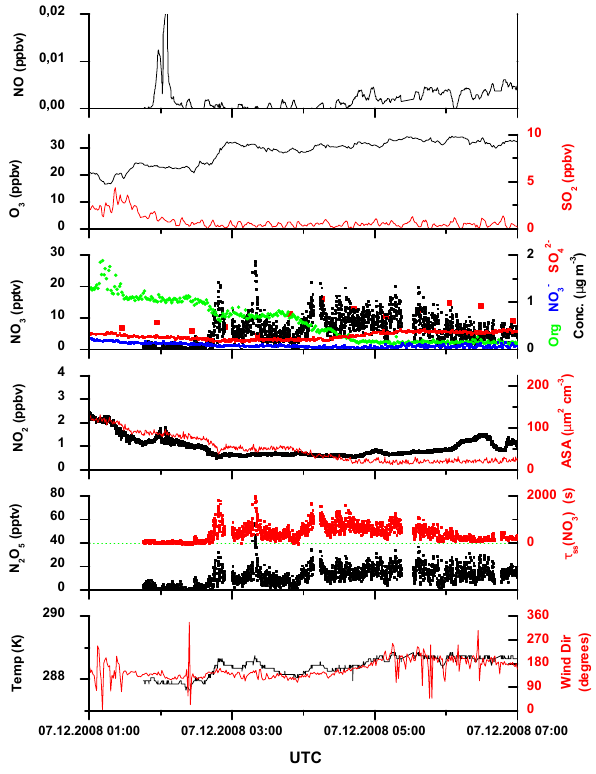
Fig. 4. Overview of measurements on the night 6–7 December (air from the Atlantic sector). ASA=Aerosol surface area. For NO 3 , the black dataponts are derived from CRD measurements of N 2 O 5 , the red squares (at ∼ 30min intervals) are LP-DOAS measurements.